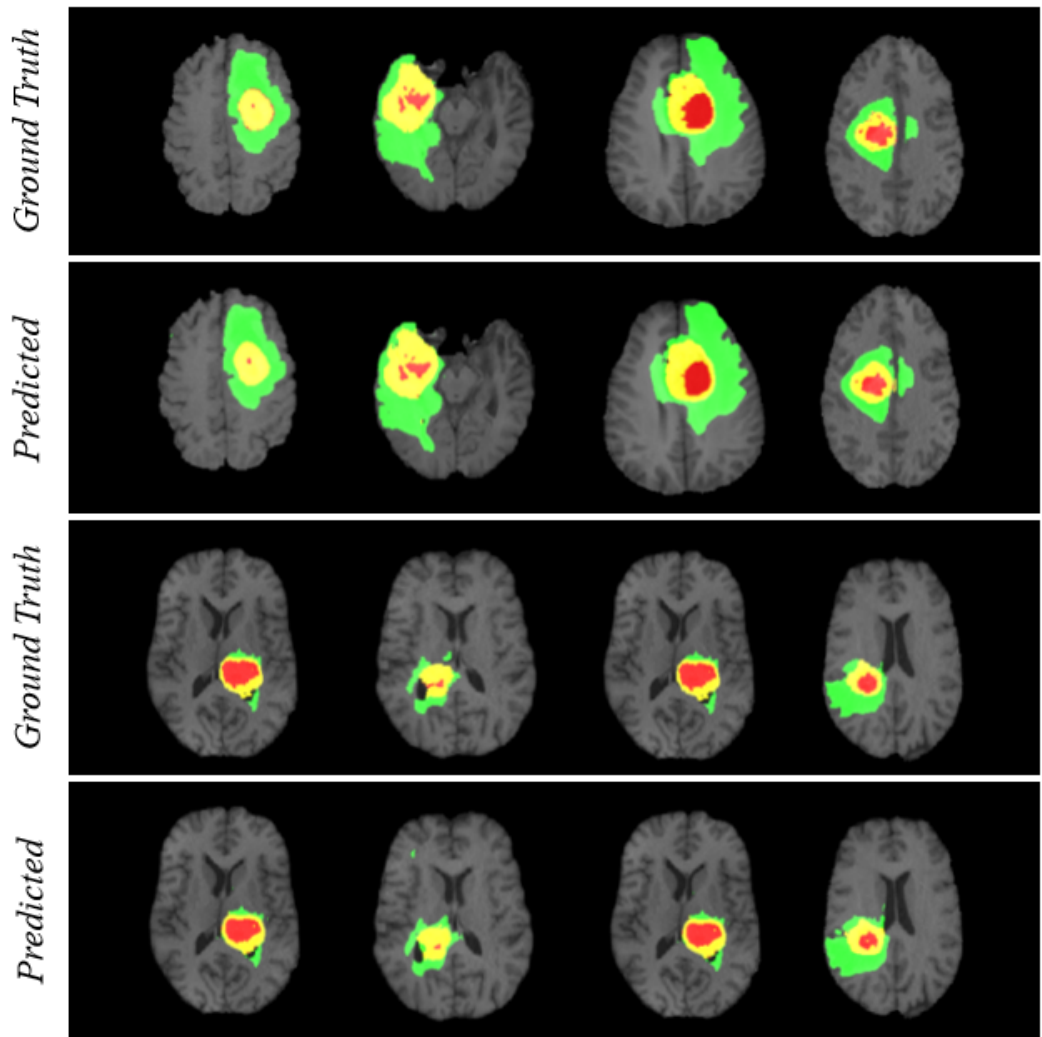
Figure 4. Visualization of segmentation performance by BrainSeg-Net architecture. Three colors in each case represents different classes. Red for necrosis and non-enhancing, green for edema, and yellow for enhancing